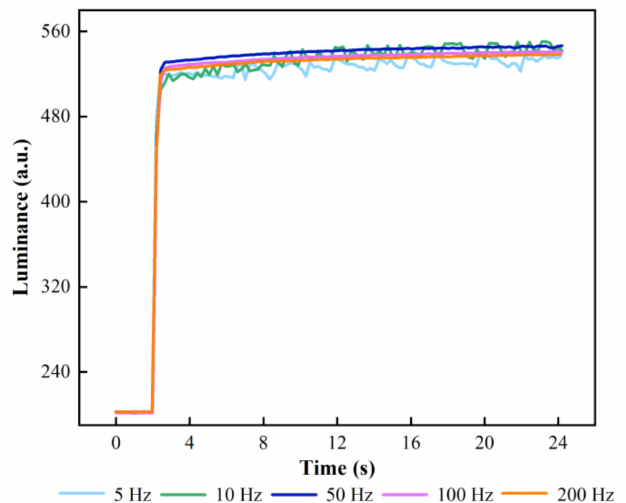
Figure 11. Luminance curves with different f s of the stabilizing stage in the proposed driving waveform. The luminance curve showed a severe oscillation when f was less than 50 Hz. The saturation luminance of EFDs was decreased when f was greater than 50 Hz. This is because the short duration of the negative voltage in the AC pulse signal, trapped charges in the insulating layer could not be released in time. The saturation luminance was maximum and the luminance curve had no significant oscillation when f was 50